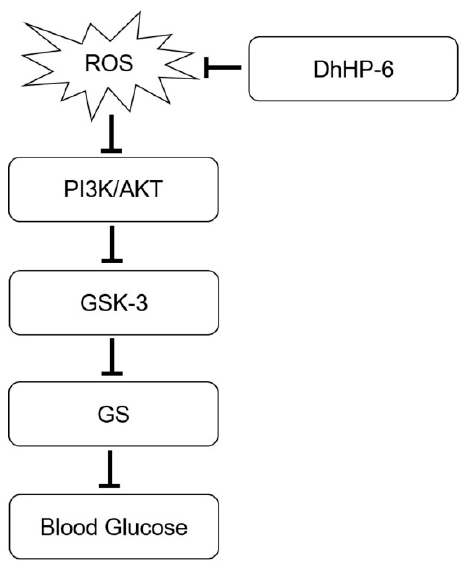
Figure 10. The possible role of DhHP-6 in type 2 diabetes experimental model. ROS impairs PI3K/AKT pathway. AKT stimulation phosphorylates and inactivates GSK-3, which subsequently results in inhibition of GS by phosphorylation. Inactivation of GS blocks glycogen synthesis and increases blood sugar. ROS, Reactive oxygen species; GSK-3, glycogen synthase kinase-3; GS, glycogen synthase.